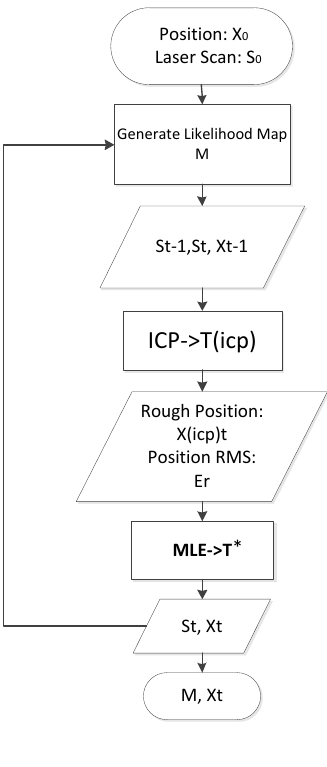
Figure 2. Flow chart of the fusion position